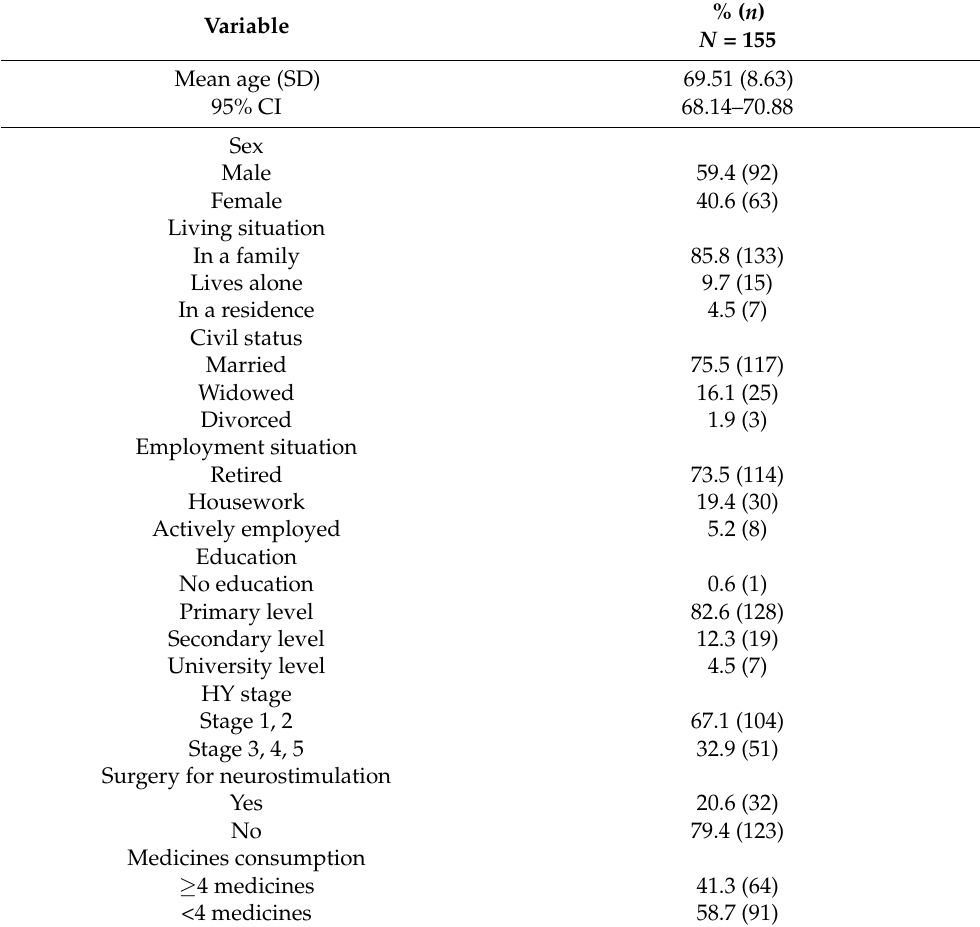
Table 1. Sociodemographic and clinical characteristics of the study